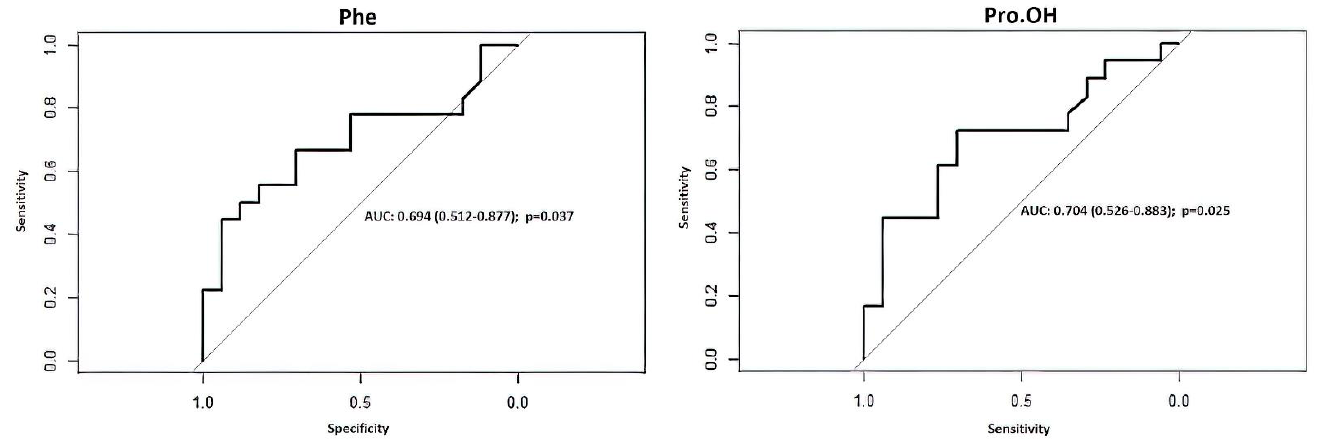
Figure 5. ROC analysis of selected amino acids in prediction of CVS has proved the predictive potential of phenylalanine (Phe) and hydroxyproline (Pro-OH). Area under the curves (AUC) were provided with their 95% confidence interval in parenthesis.